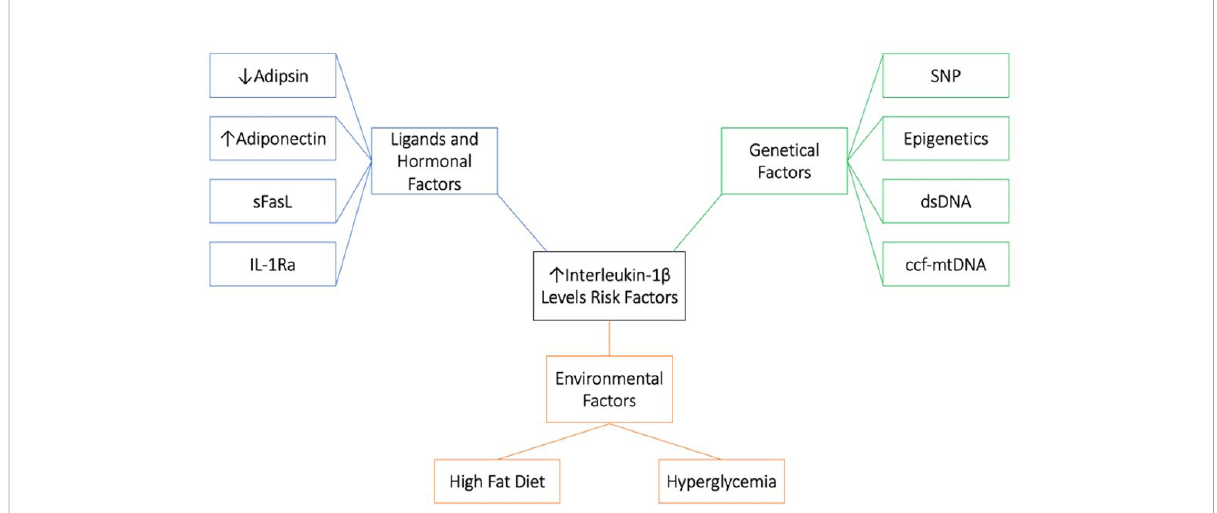
FIGURE 5 Risk factors associated with high IL-1 b levels. 1. Genetical factors; single-nucleotide polymorphism (SNP), Epigenetics, double stranded DNA (dsDNA) and circulating cell-free mitochondrial DNA (ccf-mtDNA). 2. Environmental factors; high fat diet and hyperglycemia. 3. Ligand and hormonal factors; low adipsin levels, high adiponectin levels, soluble Fas ligand (sFasL) and IL-1 receptor antagonist